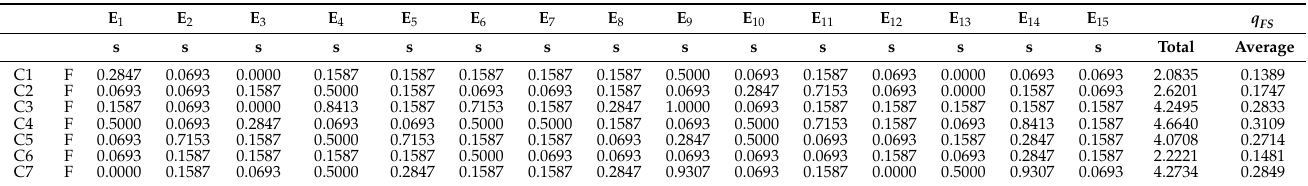
Table 13. Opposite comparison matrix for possible outcomes of “failure” in Taiwan.